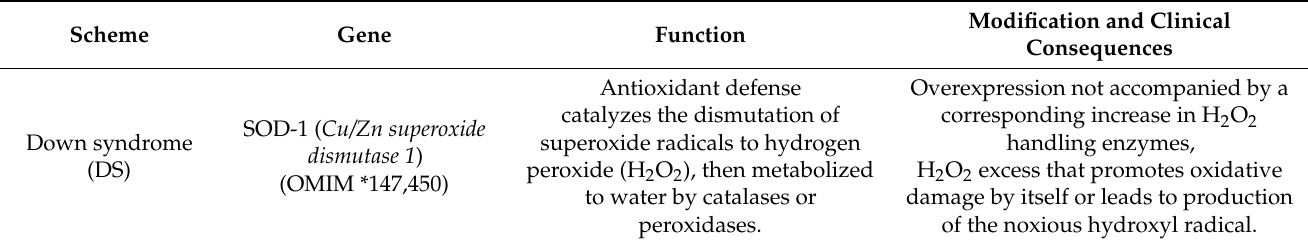
Table 1. Summary table of major altered genes by syndrome and their respective clinical